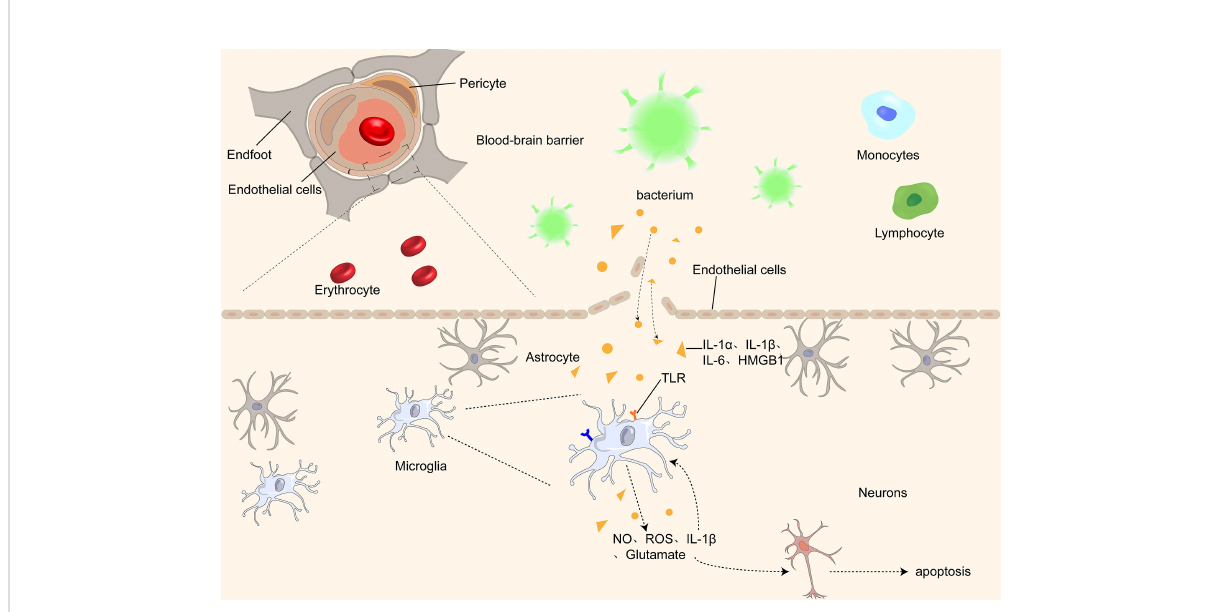
FIGURE 1 Proin fl ammatory cytokines, such as IL-1 a , IL-1 b , IL-1, and HMGB1, pass through the BBB through different receptors and activate microglia, which further damage the BBB by releasing in fl ammatory factors, causing an in fl ammatory cascade. At the same time, microglia release ROS and NO, causing damage and even apoptosis of neurons in the